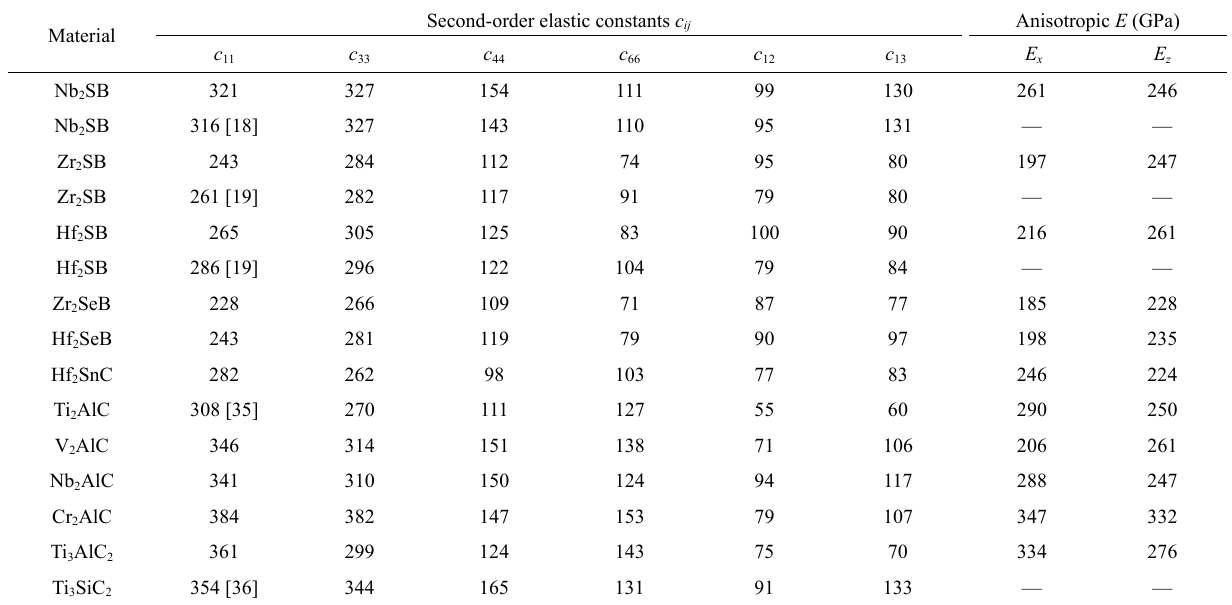
Table 2 Second-order elastic constants and anisotropic E of single crystalline M 2 AB (M = Nb, Zr, Hf; A = S, Se) together with some of the well-known MAX phases Material